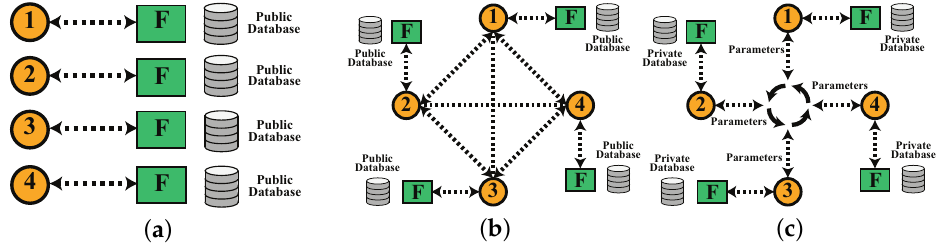
Figure 1. ( a ) shows the local learning where each BAS algorithm is assigned to one portfolio, and the objective is to optimize the respective portfolio. ( b ) shows the swarm architecture, where the swarm has access to a public database, where particles coordinate to obtain an optimal solution without considering the privacy of the database. ( c ) shows the distributed architecture, where particles only share the parameters, i.e., gradients, instead of the private information of the portfolios, i.e., private database, stock information, and client